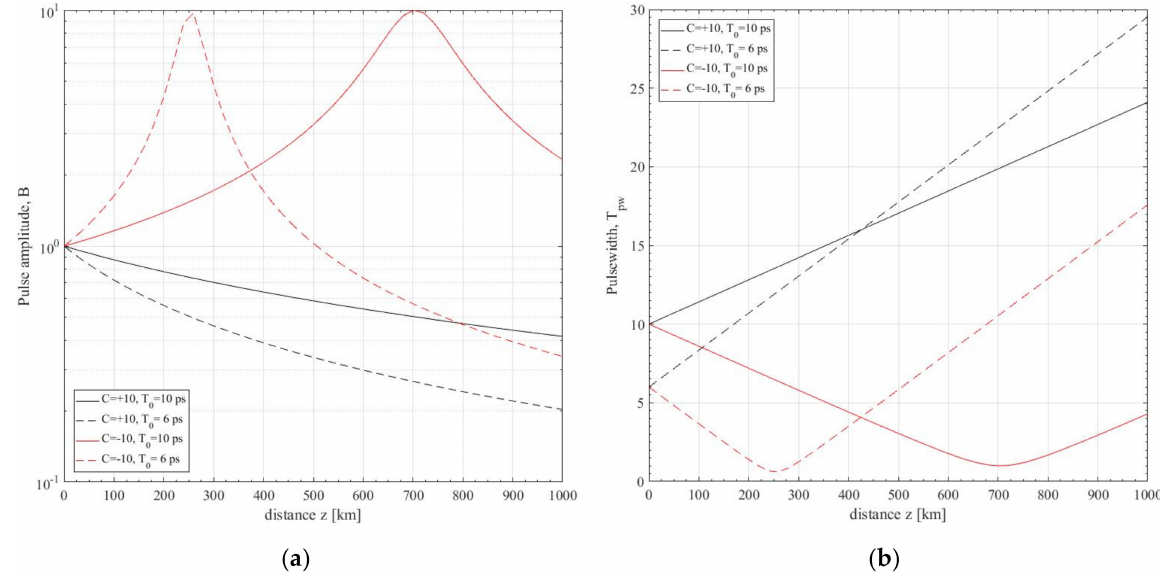
Figure 2. ( a ) The amplitude of the propagating pulse along z -axis, supposing the original amplitude equal to unity; ( b ) the corresponding pulse width evolution along